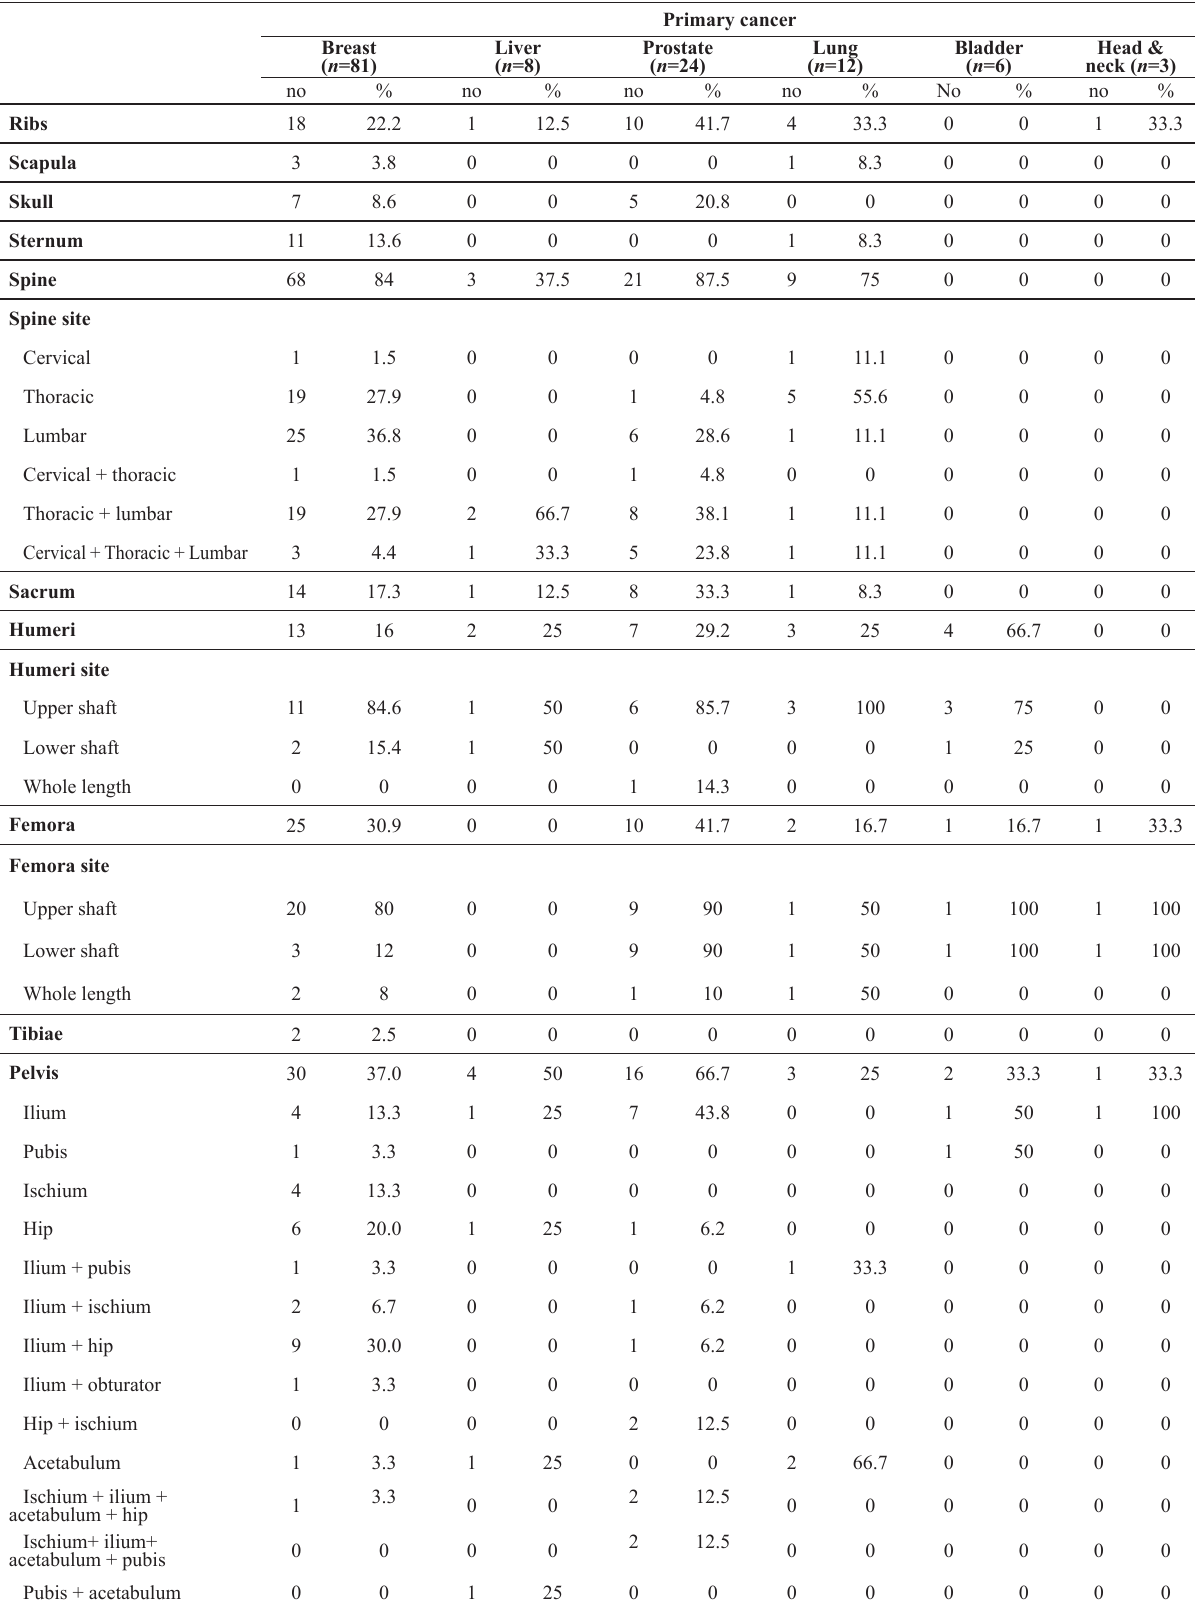
Table 3: Distribution of bone metastases according to primary